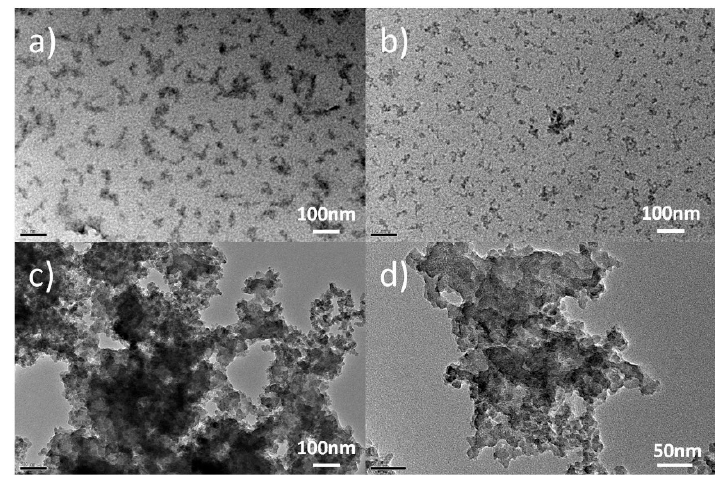
Figure 3. TEM images of ( a , b ) pure SS and ( c , d ) PDMS-SiO 2 /SS.